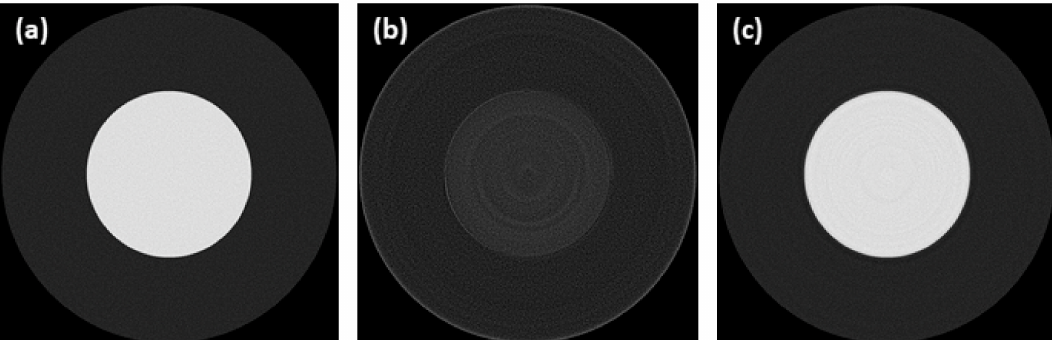
Figure 9. Comparison of data distortion between the proposed method and M2 method—tomograms of ball phantom: ( a ) reference; ( b ) M2 method; ( c ) proposed. For visualization, the same contrast setting was used for all the images.